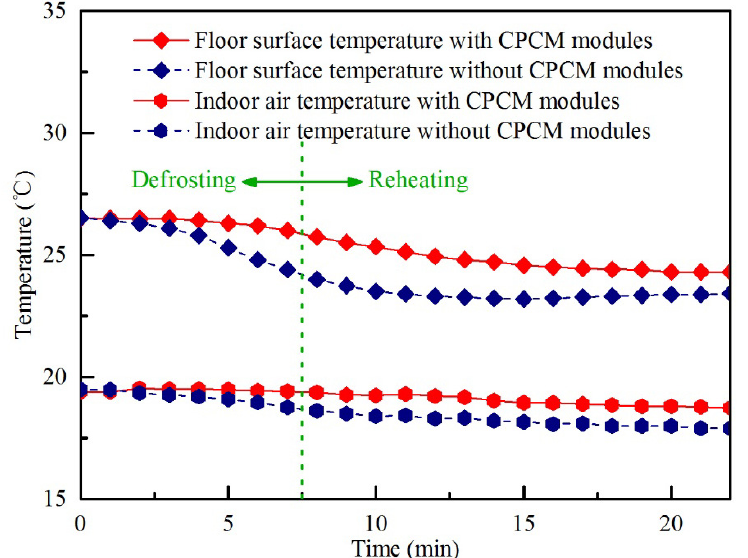
Figure 10. Temperature variations of radiant floor surface and indoor air with and without CPCM modules in defrosting condition.